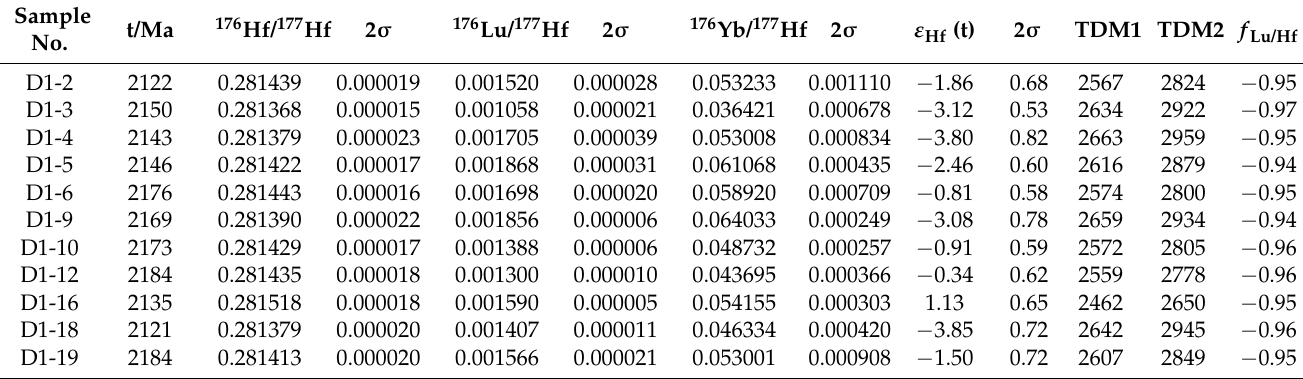
Table 4. Lu–Hf isotopic data of zircons from Tongkuangyu granodiorite